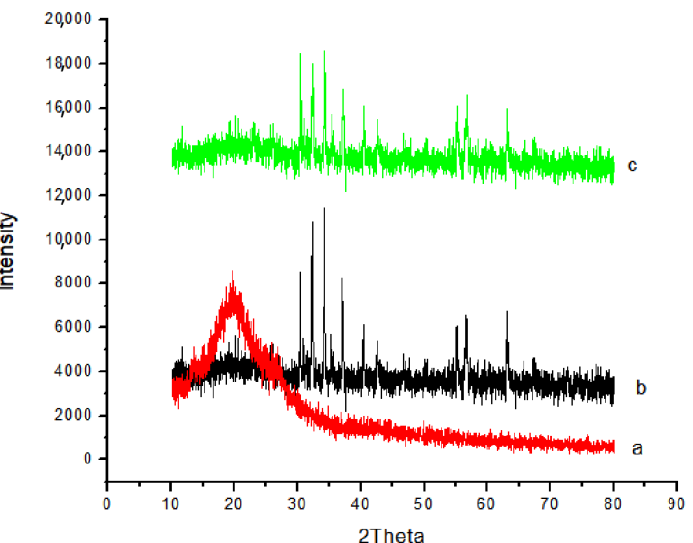
Figure 3. XRD patterns of (a) the pure PPy, (b) the pure BaFe 12 O 19 , and (c) the BaFe 12 O 19 -PPy com- posite.